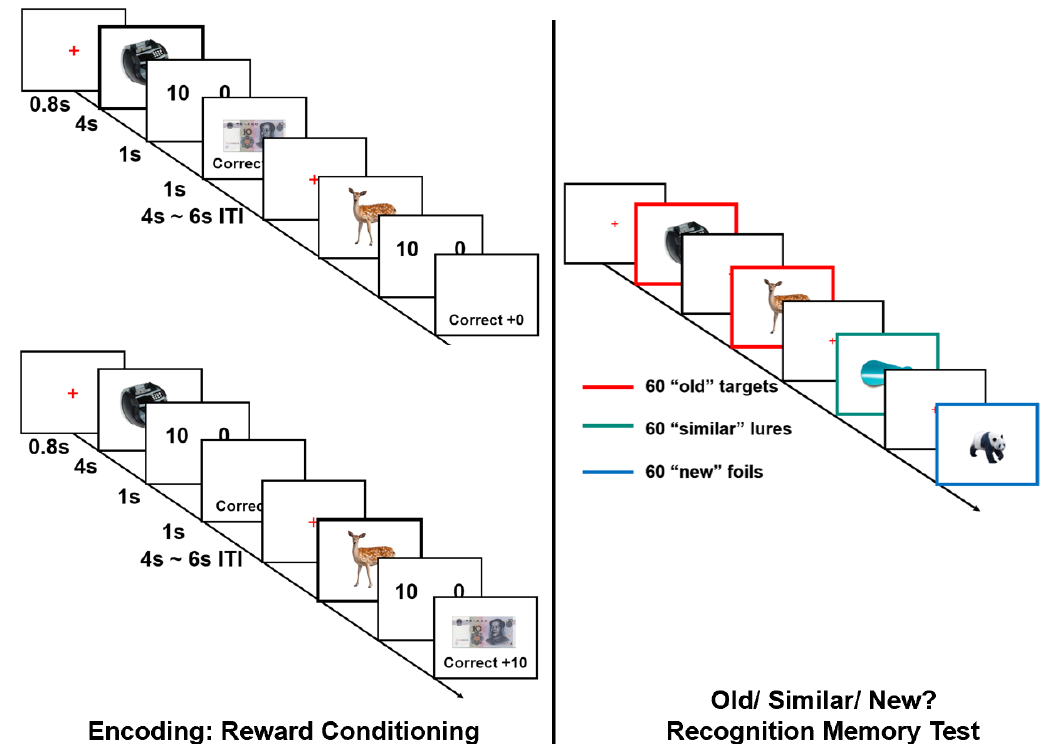
Figure 1. In the incidental encoding task, participants encode pictures incidentally by completing a value-guessing task. In the recognition memory test, participants were asked to identify whether the picture was old, similar, or new. Bold and colored borders were used only for illustration purposes and were not part of the stimuli shown to participants.